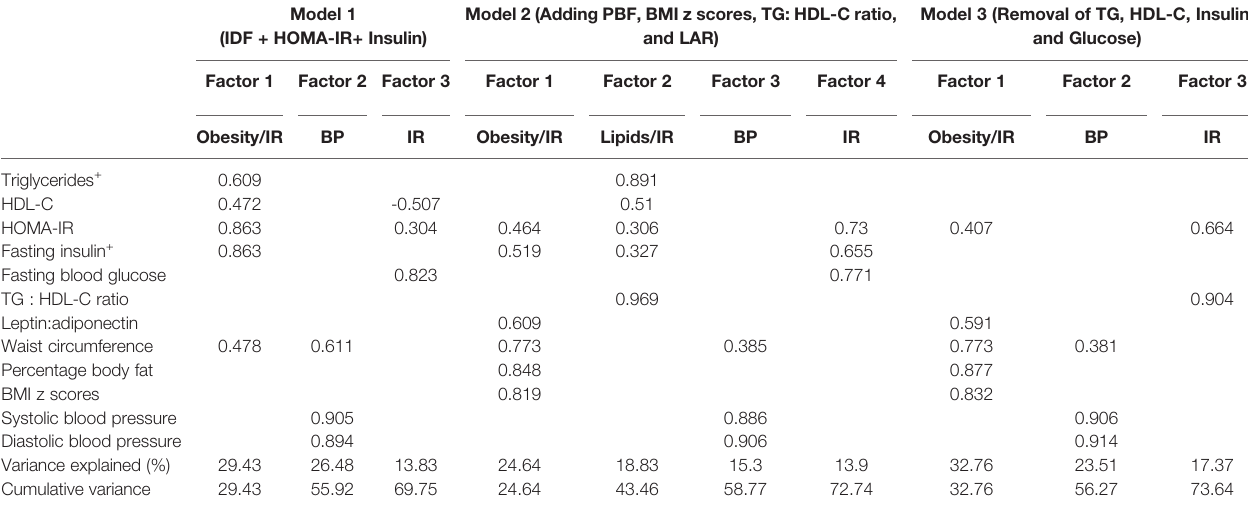
TABLE 4 | Factor loadings of traditional variables with or without TG: HDL-C ratio, LAR, PBF, BMI z-scores, and